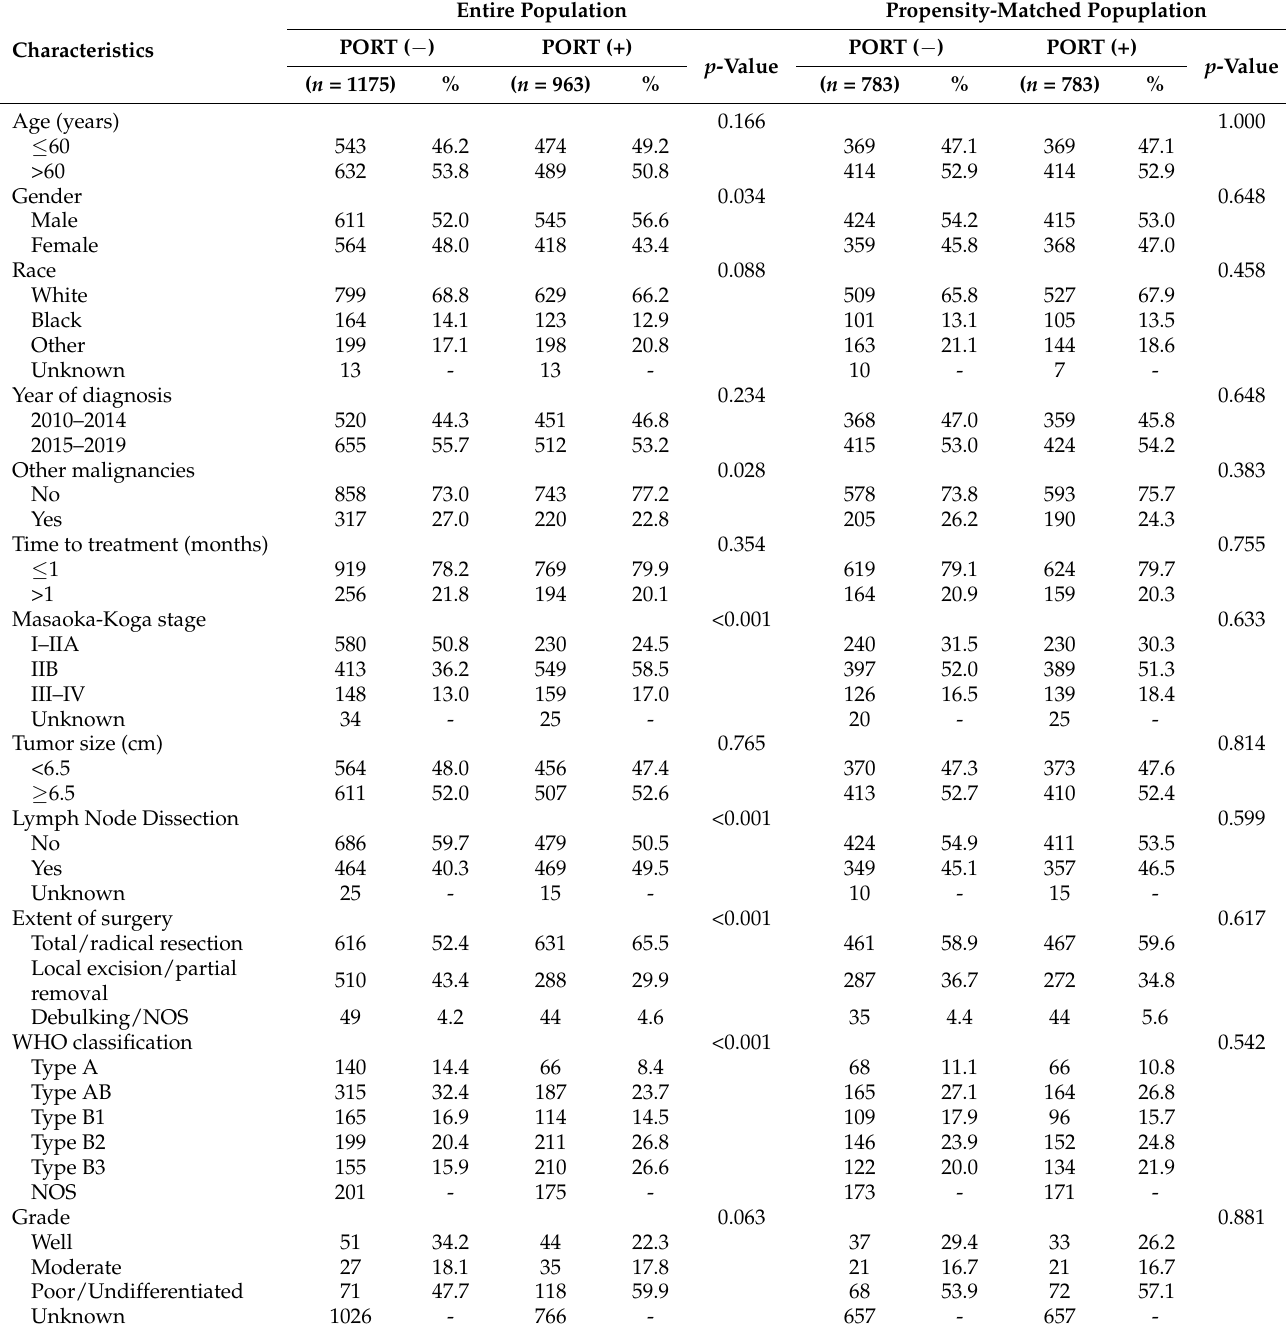
Table 2. Characteristics of thymoma patients before and after propensity score